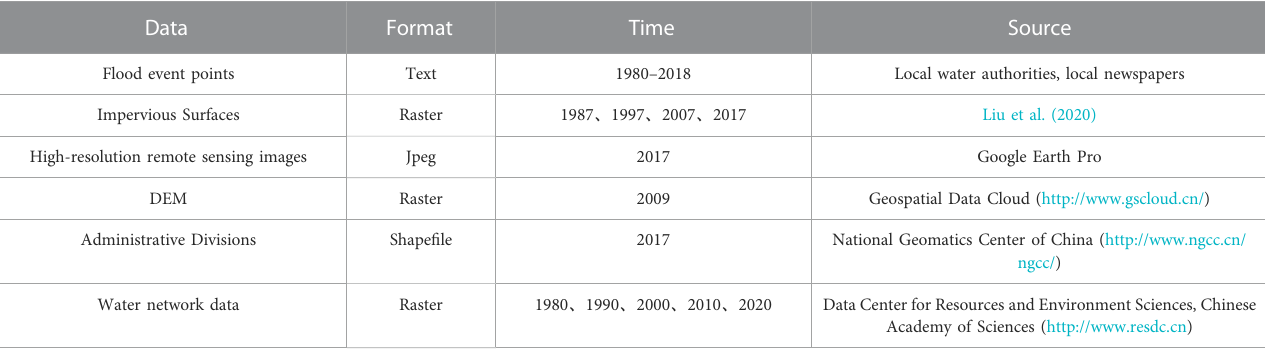
Table 1. We mainly use the textual information of urban fl ooding event points, impervious surface data with 30 m spatial resolution covering the GBA, digital elevation model (DEM) data, and administrative division